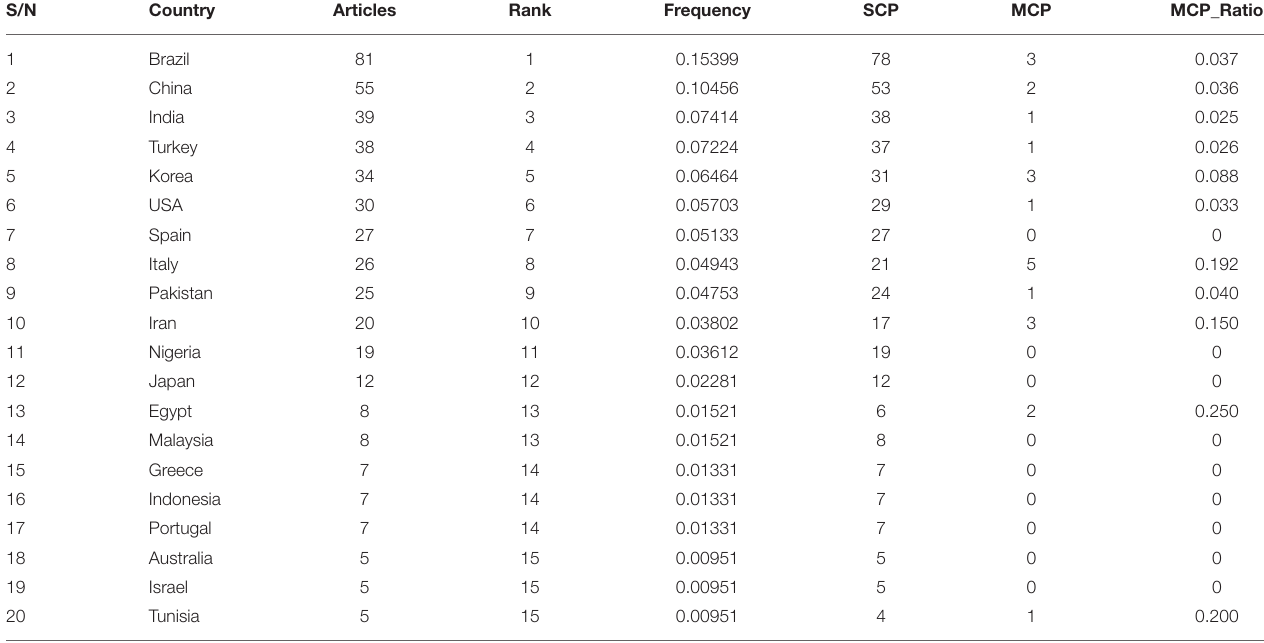
TABLE 3 | The top 20 publications by countries in the field of citrus waste and animal feed production for livestock research. S/N